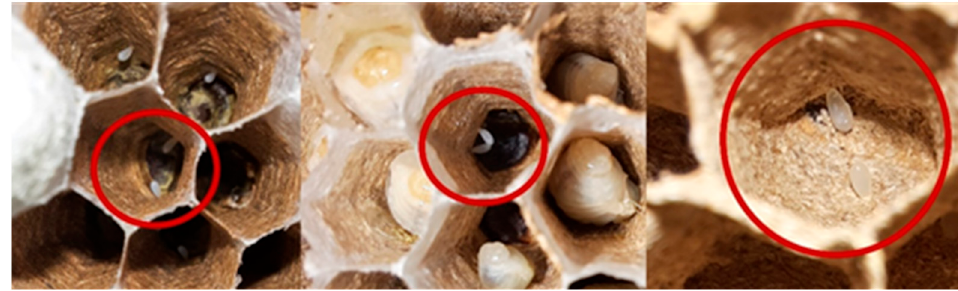
Figure 6. Two eggs per cell in different declining nests.